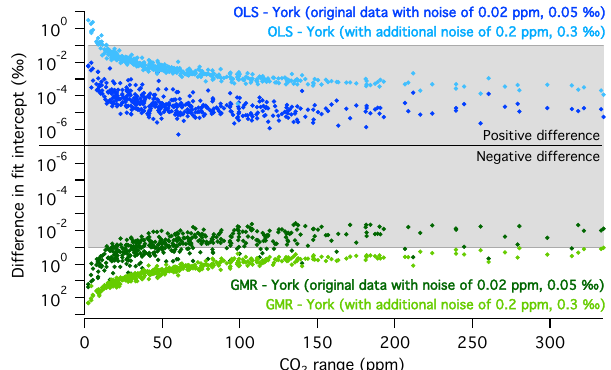
Figure 3. Difference between the fit intercept obtained by OLS or GMR and that obtained by York’s equations, for 429 real mea- sured Keeling plots with measurement uncertainties of 0.05ppm and 0.02‰ and with CO 2 mixing ratio ranges between 2 and 335ppm. Also shown is the difference obtained for Keeling plots in which random computer-generated noise of 0.2ppm and 0.3‰ was added to the original data. The grey region represents biases that are negligible for most practical purposes ( <